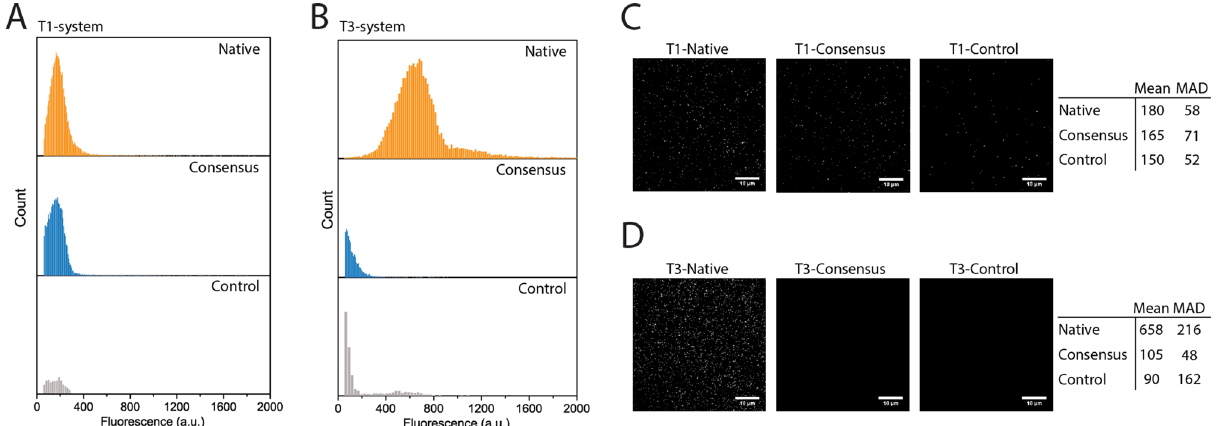
Figure 4. Single particle characterization of encapsulin cargo loading. ( A ) and ( B ) Histograms of single particle fluorescence measurements for T1 and T3 systems with different targeting peptides. ( C ) and ( D ) Example single particle fluorescence images of immobilized mNeonGreen-loaded encapsulins. The native T3 system showed greater fluorescence per particle than the T1, as expected due to the larger size and subunit number of T3. The T1 consensus showed slightly less loading than native, whereas the T3 consensus peptide showed greatly diminished loading only slightly stronger than GGS controls. Scalebar: 10 μm. Mean: mean fluorescence of measured spots. MAD: mean absolute deviation, see Eq.